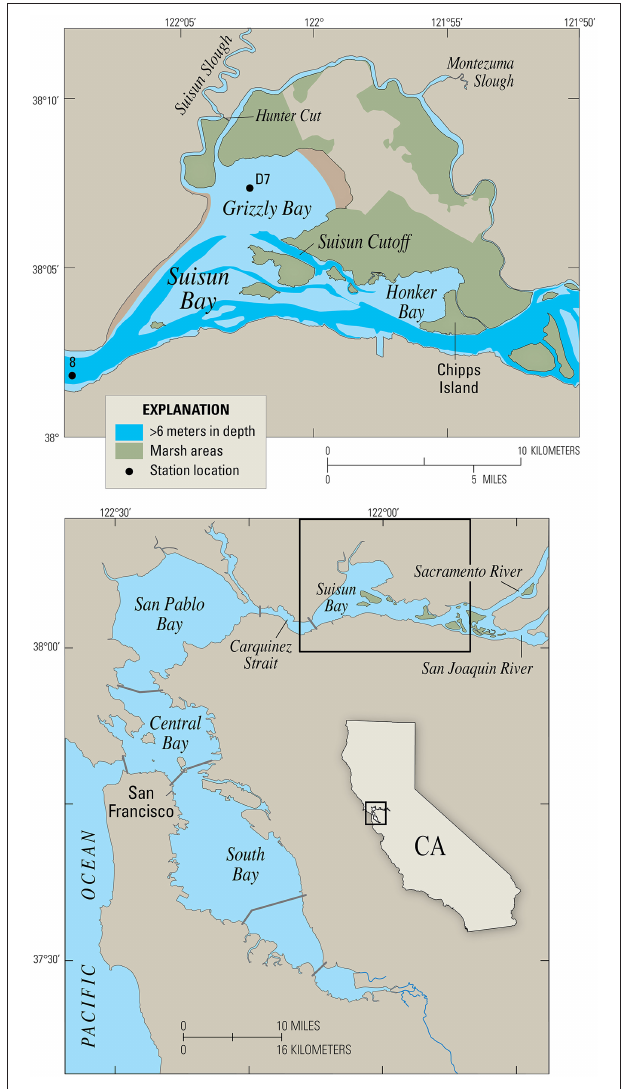
FIGURE 4 | Map of Suisun Bay, California, the case study site. Station D7 is a long-term monitoring site for the Environmental Monitoring Program of the California Department of Water Resources. Station 8 is a long-term U.S.G.S. water quality and benthos monitoring